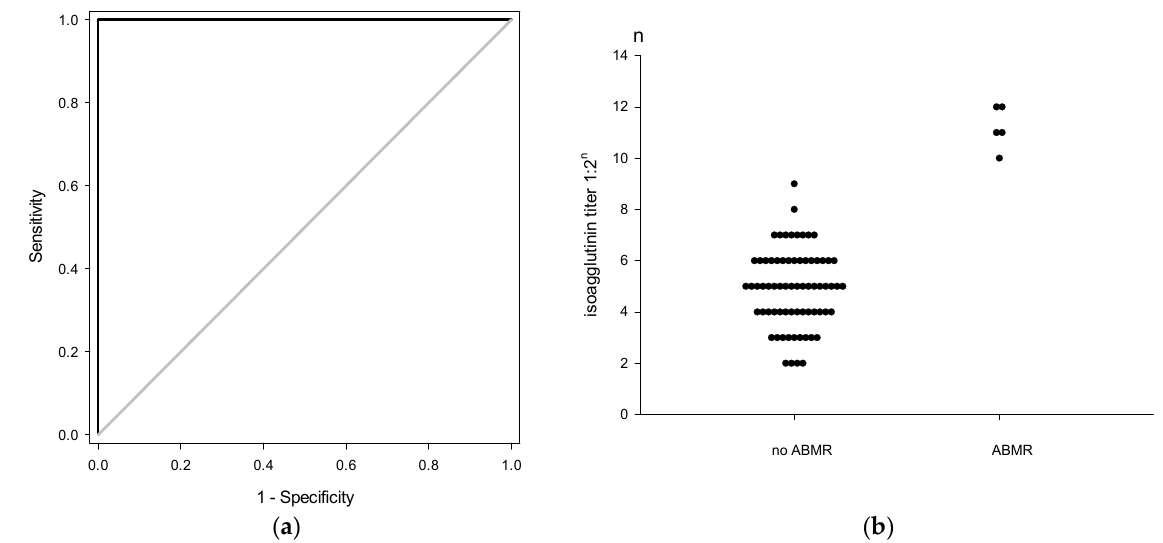
Figure 3. The threshold of postoperative isoagglutinin titer to cause AMR. ( a ) ROC curve of isoagglutinin titer to cause AMR. The best cutoff value of postoperative isoagglutinin rebound to cause clinical AMR was 1:1024 with 1.00 (95% CI: 0.48–1.00) of sensitivity and 1.00 (95% CI:0.95–1.00) of specificity. ( b ) Dot histogram of isoagglutinin titer to cause AMR. In total, 16 of 76 patients (21.1%) had postoperative isoagglutinin rebound ( ≥ 1:128). Five of them developed AMR, whose isoagglutinin rebound was ≥ 1:1024.